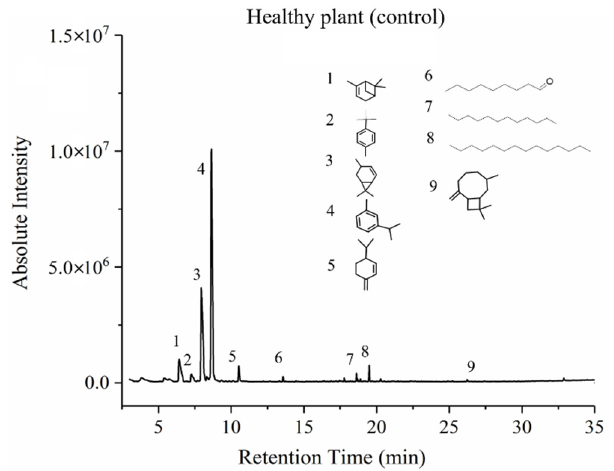
Figure 6. A typical GC-MS spectrum of VOCs from healthy tomato plant.